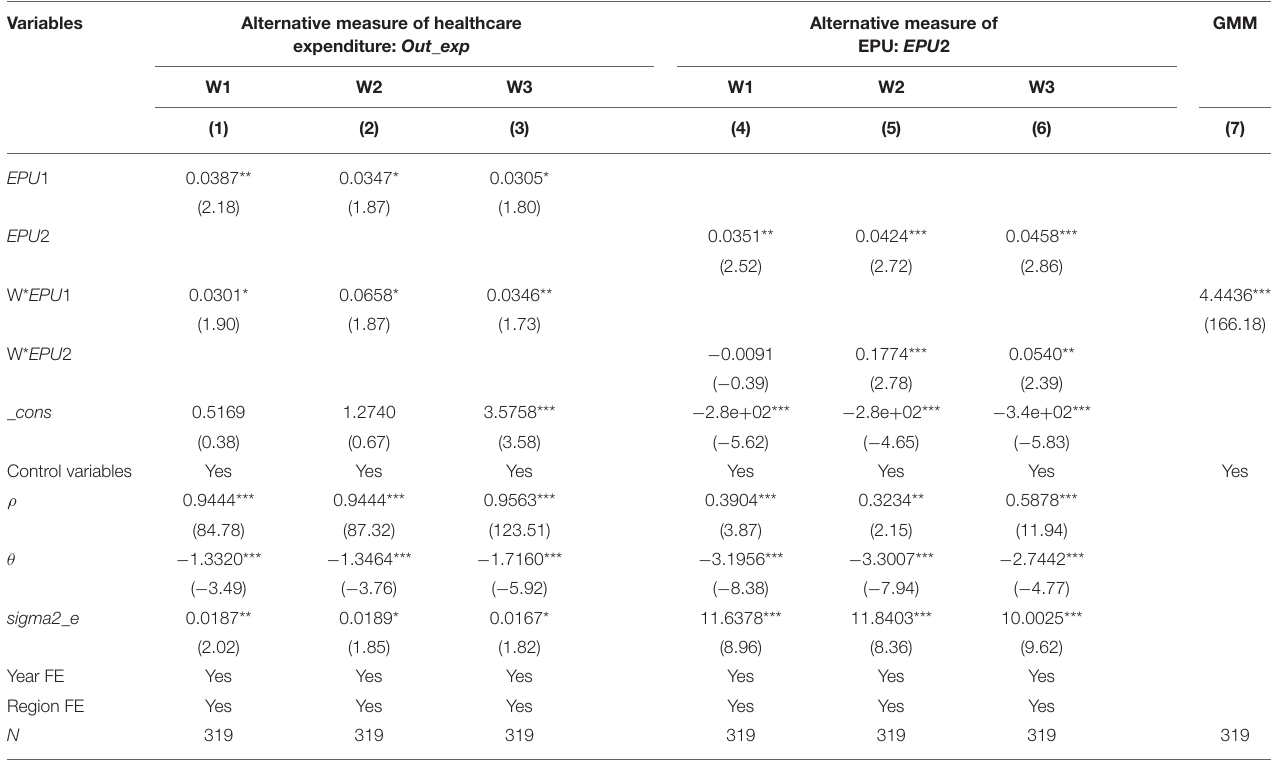
TABLE 8 | Estimation results of robustness